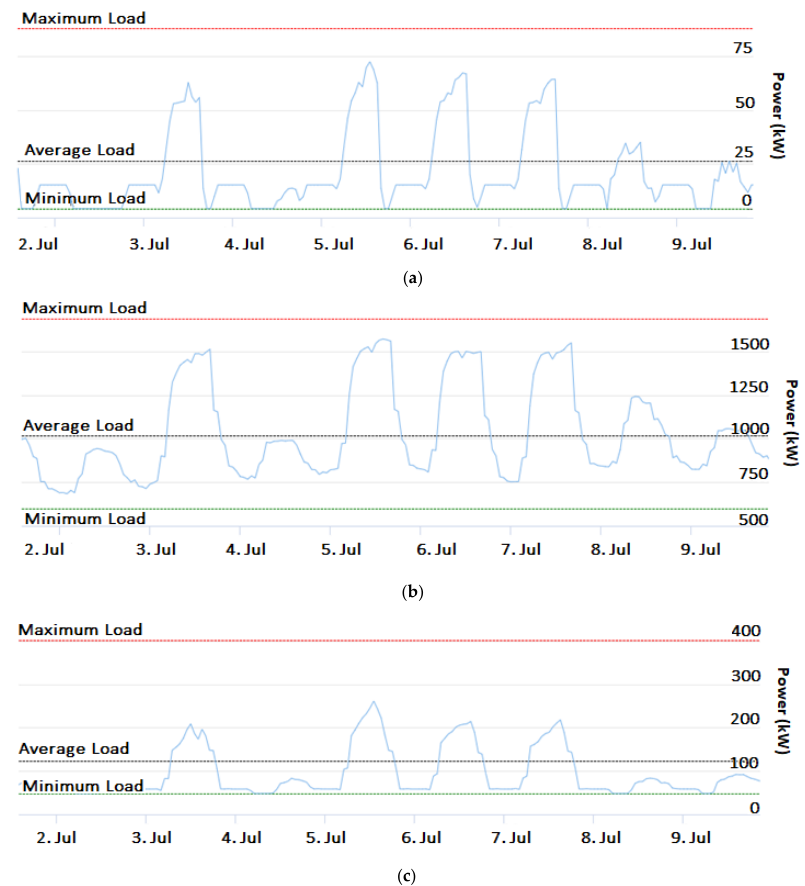
Table 1. Selected geographic locations and their respective DNI levels [29].